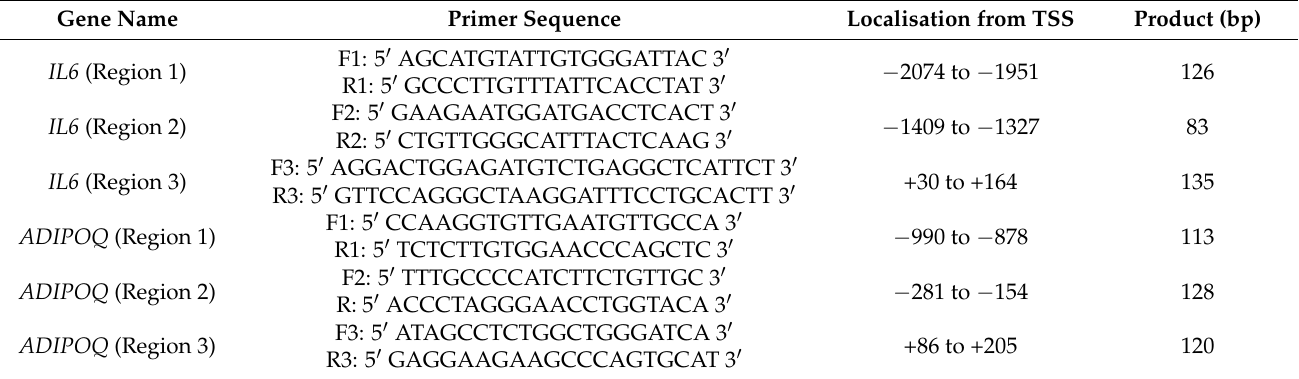
Table 1. The list of primers used for ChIP